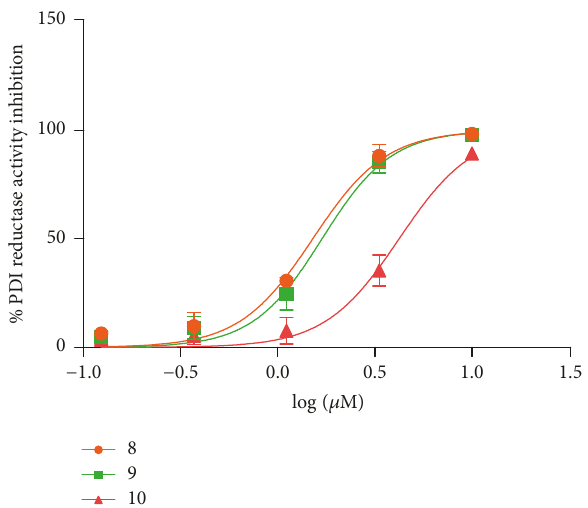
Figure 6: Dose-response curves of the most potent compounds.